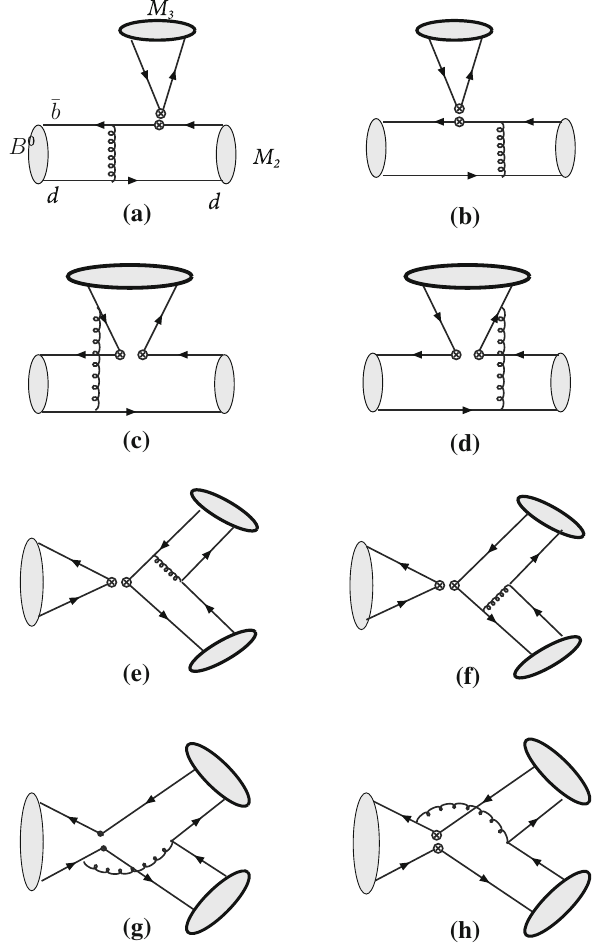
Fig. 1 Leading order Feynman diagrams in PQCD